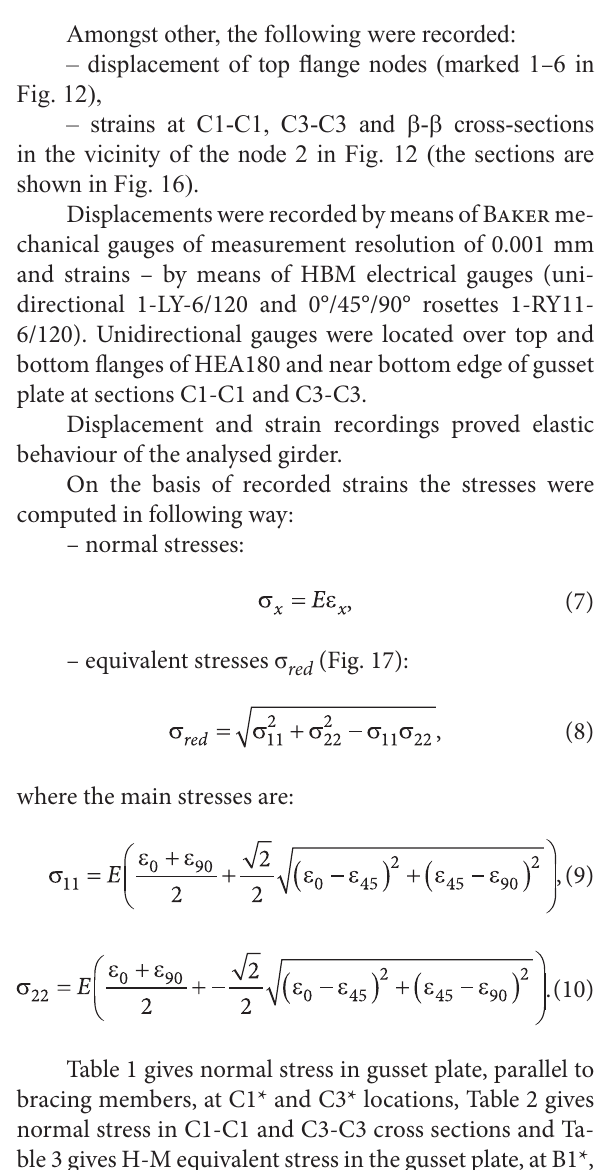
Table 2. Normal stress values Location